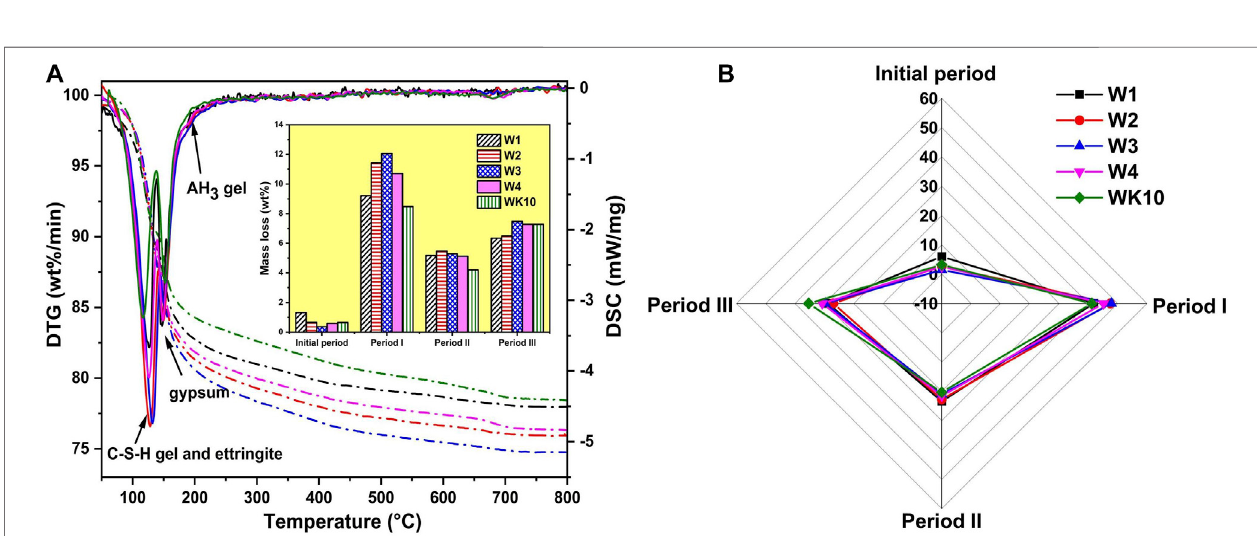
FIGURE 13 | (A) TG curves and (B) relative mass loss in each period for P-SSC binders at 28 days.